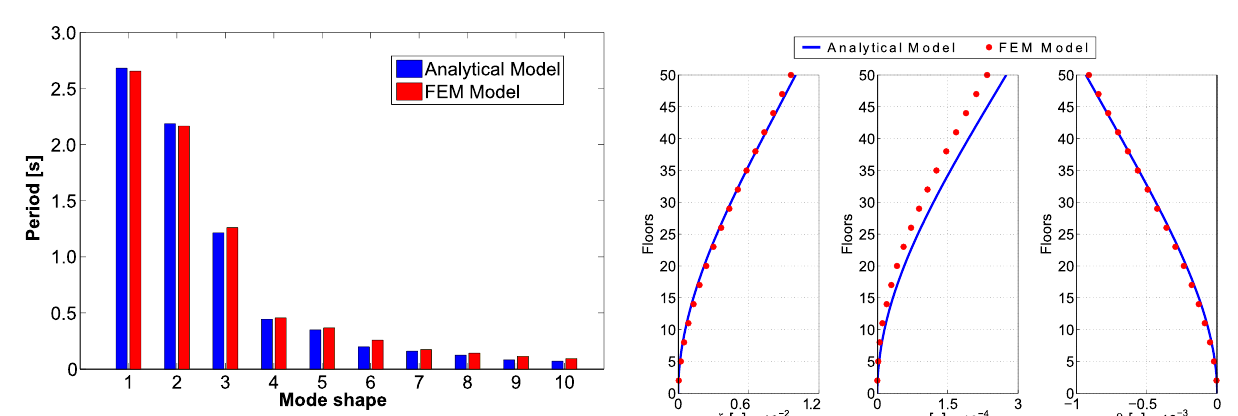
Figure 6: Normalized eigenvector components of the 3rd mode shape